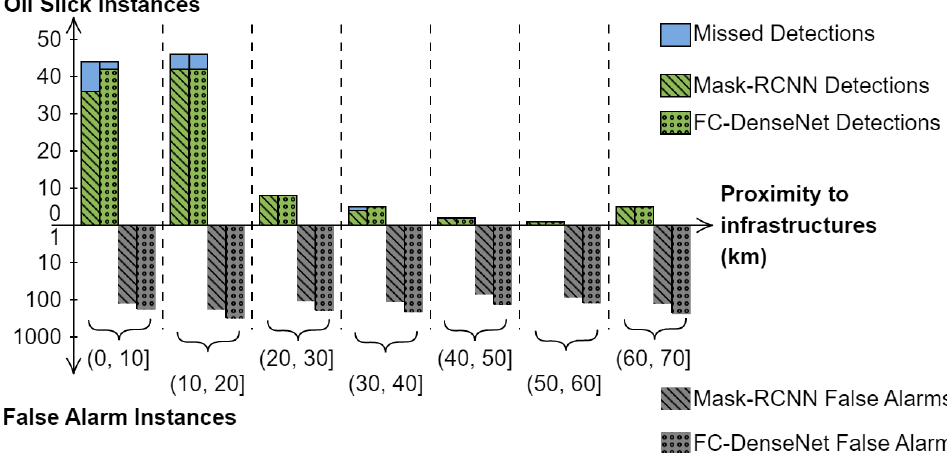
Figure 16. Detection performance of FC-DenseNet and Mask R-CNN as a function of infrastructure proximity (km), same legend as Figure